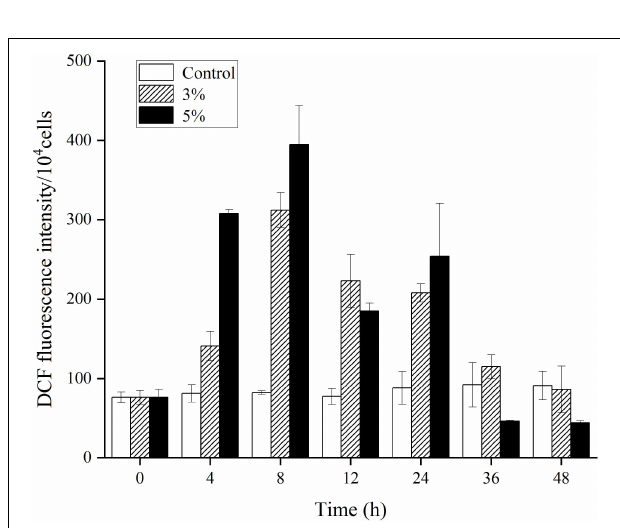
FIGURE 4 | Effects of photosynthetic efficiency (Fv/Fm) within Karenia mikimotoi treated with varying doses of Paracoccus homiensis O-4. Error bars represent the standard deviation of the triplicates.